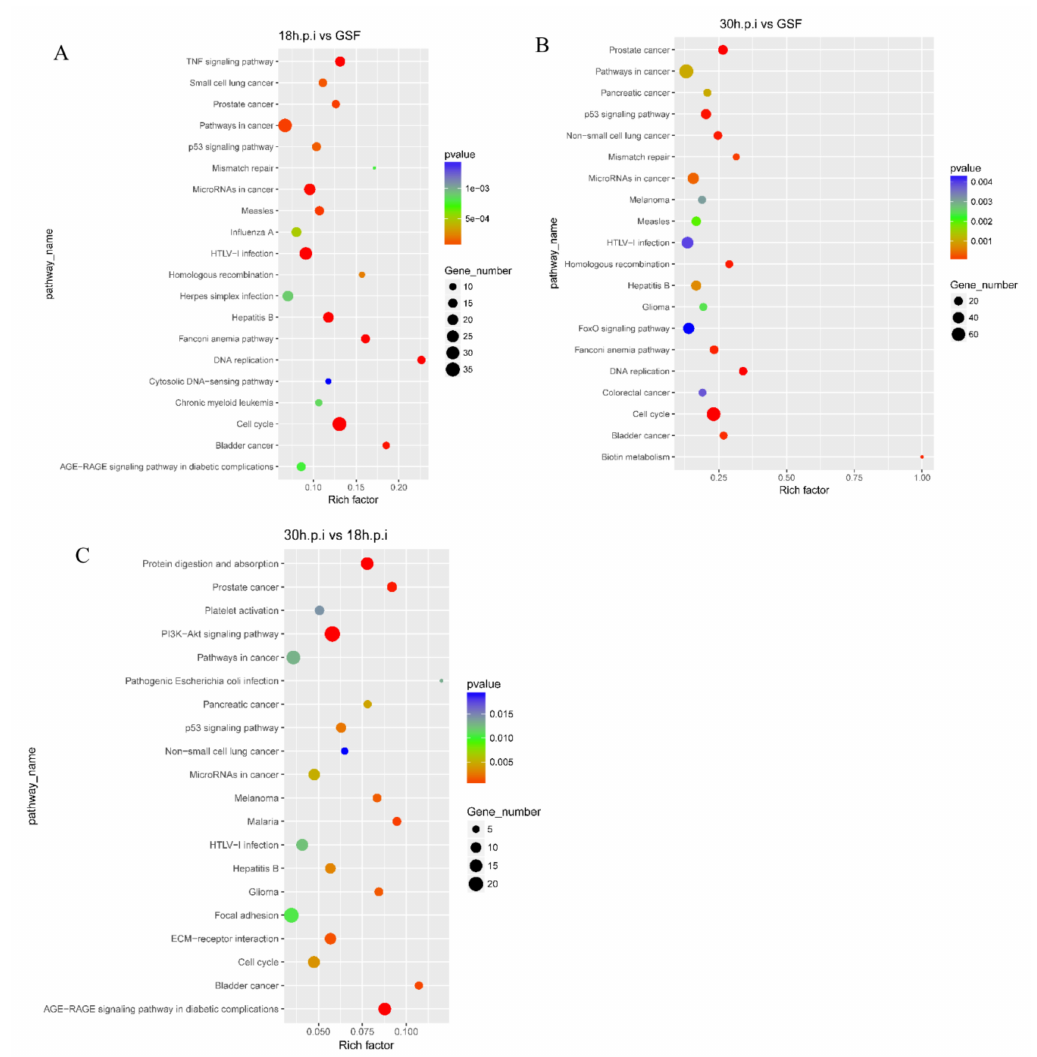
Figure 7. KEGG enrichment analyses of DEGs in 18h.p.i vs. GSF, 30h.p.i vs. GSF and 30h.p.i vs. 18h.p.i. ( A ). KEGG enrichment analysis of DEGs in 18h.p.i vs. GSF. ( B ) KEGG enrichment analysis of DEGs in 30h.p.i vs. GSF. ( C ) KEGG enrichment analysis of DEGs in 30h.p.i vs.